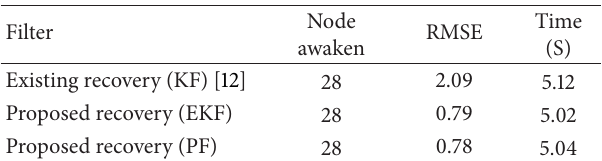
Table 4: Performance comparison: communication failure—Case I